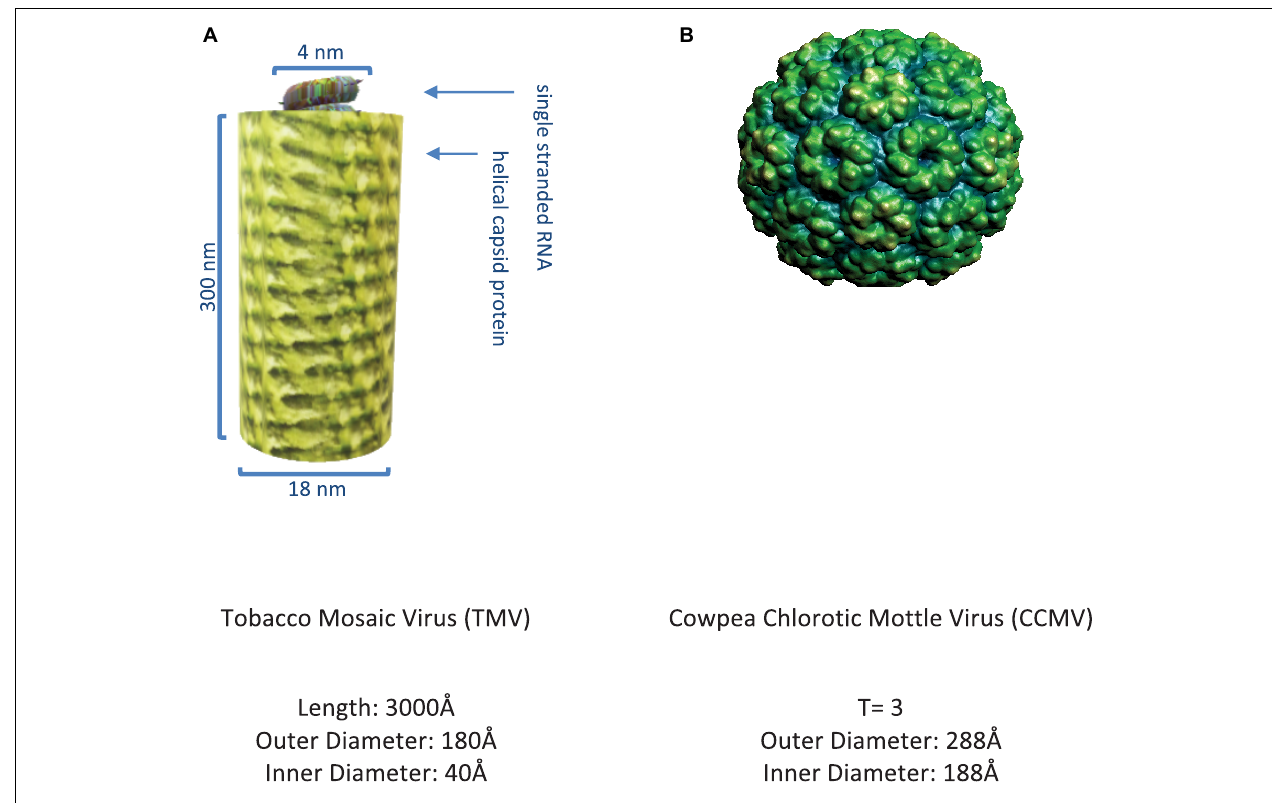
FIGURE 3 | Representative plant viruses. (A) Image of tobacco mosaic virus (Namba and Stubbs, 1986) rendered on MS PowerPoint. (B) Image of cowpea chlorotic mottle virus (Speir et al., 1995) as obtained from VIPER (Carrillo-Tripp et al., 2009).